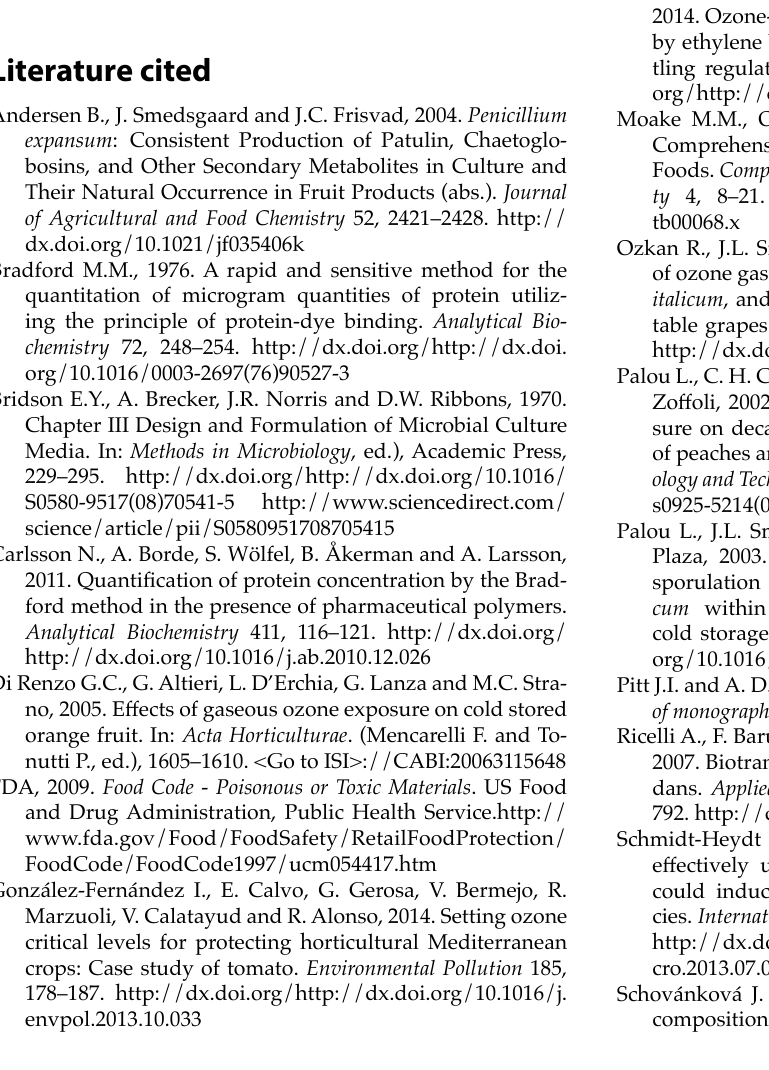
table grapes. Postharvest Biology and Technology 60,